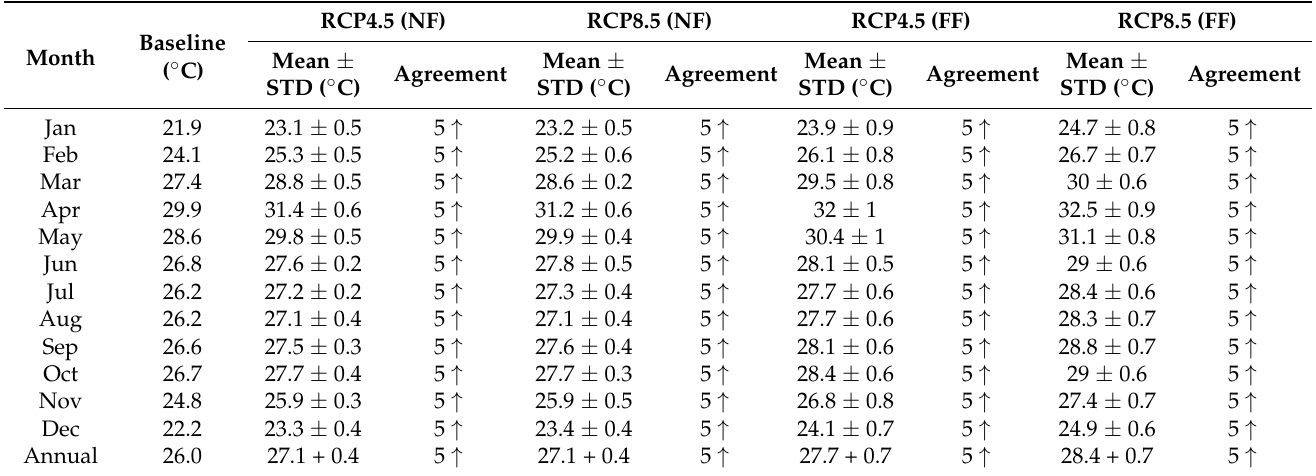
Table 6. Baseline ( ◦ C) and projected mean and standard deviations of basin temperature ( ◦ C) changes ( ◦ C) under RCP4.5 and RCP8.5 scenarios for near and far future and agreement among the GCMs for the direction of change. The arrows in agreement indicate the direction of change with up arrow indicating increase and down arrow indicating decrease from baseline